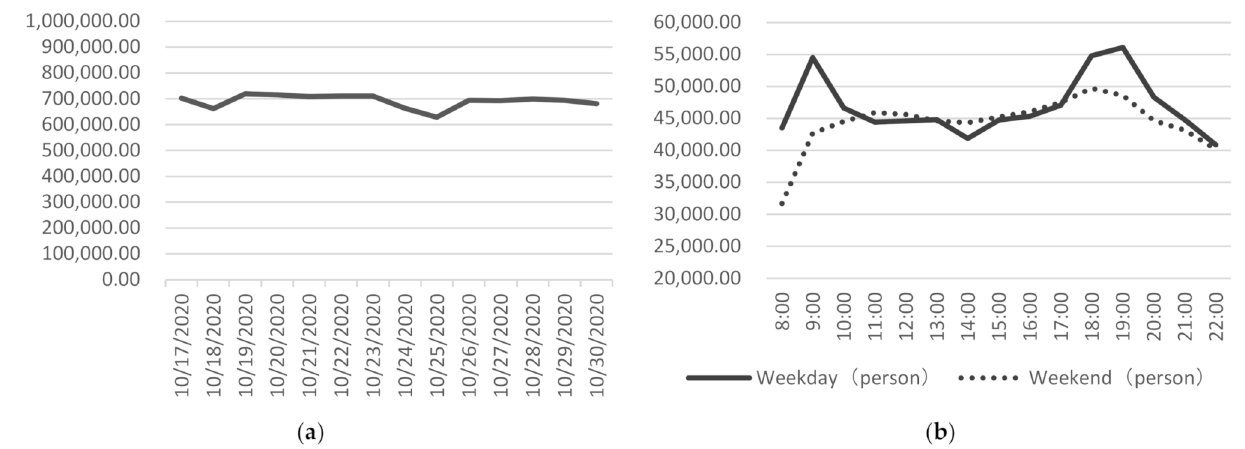
Figure 2. Processing of the LBS big data: ( a ) Changes of street activities during the 14 days; ( b ) changes of street activities during the daytime.